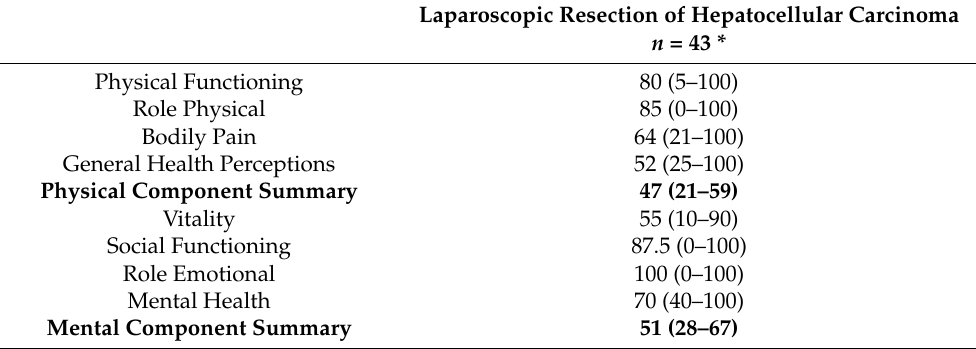
Table 2. Health-related quality of life measured with Short Form 36 questionnaire (SF-36) after laparoscopic liver resection for hepatocellular carcinoma